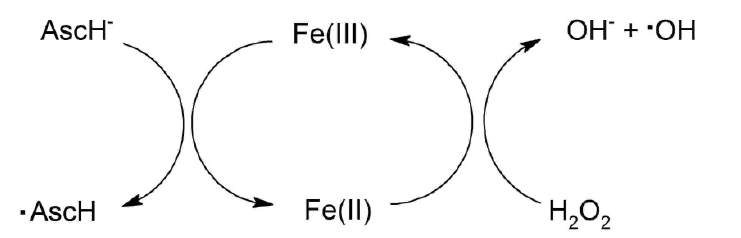
Scheme 1. The AA-driven cyclic Fenton reaction. A schematic representation of the reduction of Fe(III) ion and the formation of hydroxyl radical in the presence of hydrogen